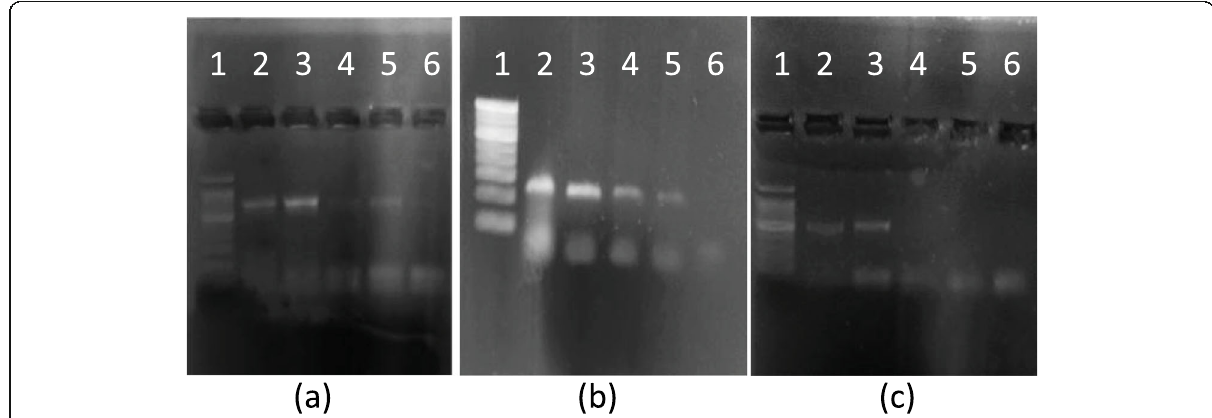
Fig. 4 Paper size and culture volume optimization. a 16s r-DNA: lane 1 — 100 bp ladder, lane 2 — colony PCR, lane 3 — 1 mm × 1 mm size ppr with 2 μ L CS, lane 4 — 3 mm × 3 mm size ppr with 3 μ L CS, lane 5 — 5 mm × 5 mm size ppr with 5 μ L CS, lane 6 — negative control. b β -galactocidase lane 1 — 100 bp ladder, lane 2 — colony PCR, lane 3 — 1 mm × 1 mm size ppr with 2 μ L CS, lane 4 — 3 mm × 3 mm size ppr with 3 μ L CS, lane 5 — 5 mm